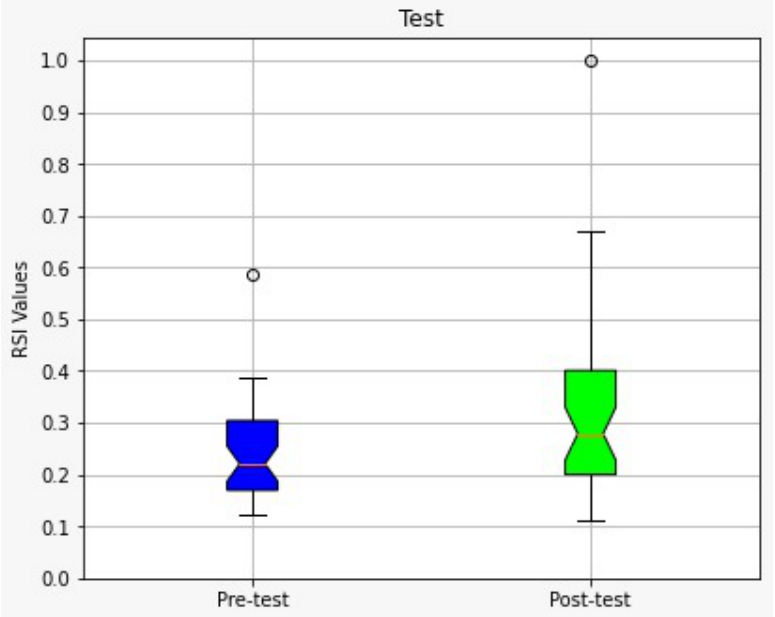
Figure 7. Boxplot diagram corresponding to the pre-test and post-test performance of all subjects.